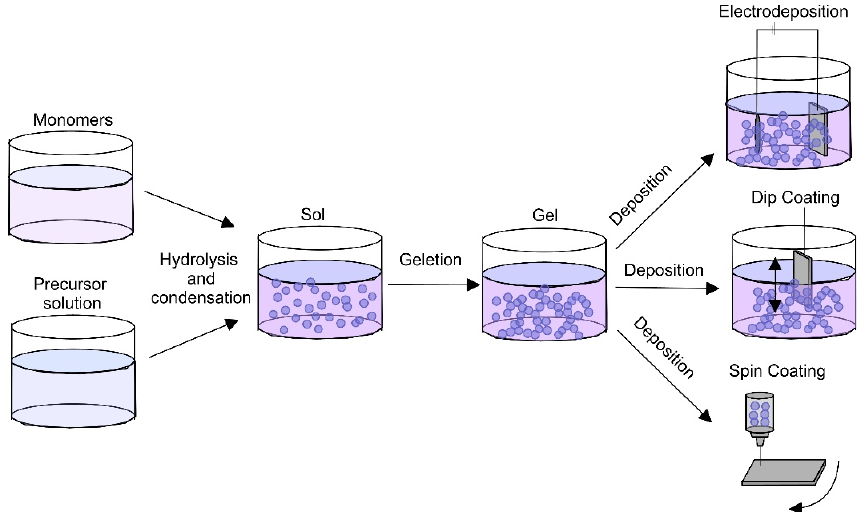
Figure 4. Schematic view of preparation of sol-gel preparation of coatings. Based on the type of drying method, the end product type can vary substantially.